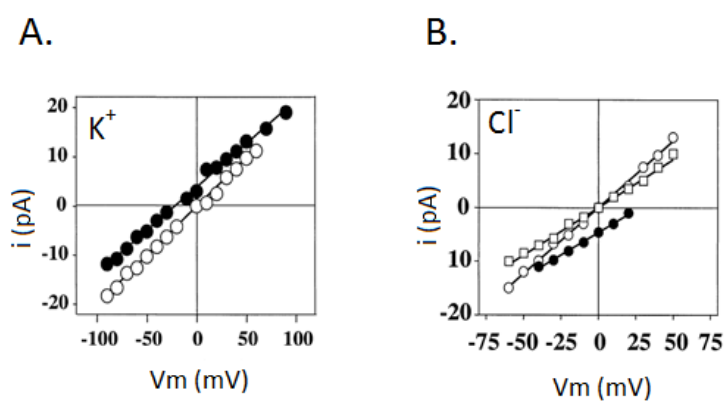
Figure 5. Current–voltage relationship curves of ( A ) the intermediate K + -selective nuclear ionic channels in asymmetrical 150/50 mM ( ● ) KCl and in symmetrical 150/150 mM ( ○ ) KCl conditions and ( B ) Cl − -selective nuclear ionic channels in asymmetrical 150/50 mM ( ○ ) KCl and in symmetrical 50/50 mM ( □ ) or 150/150 mM ( ● ) KCl conditions